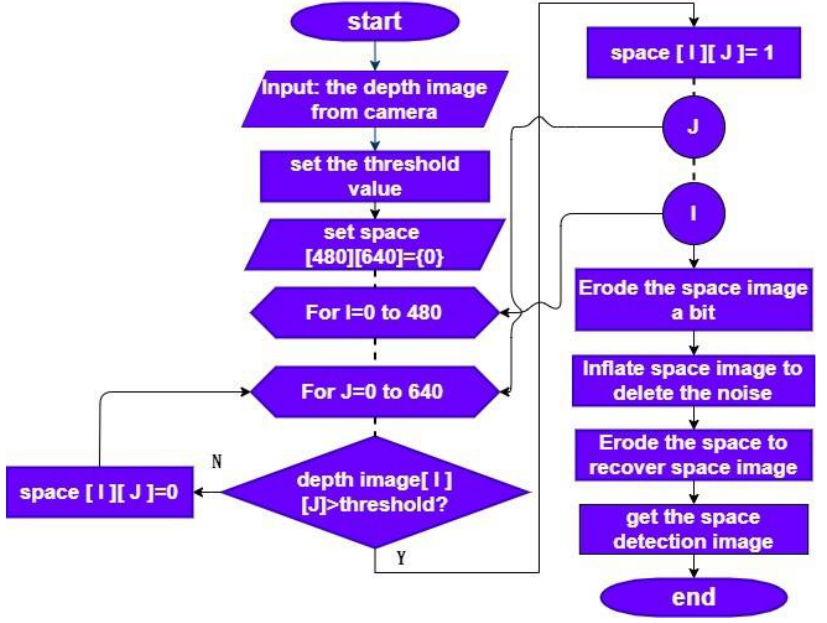
Figure 8. Noise removal and spatial detection flow.